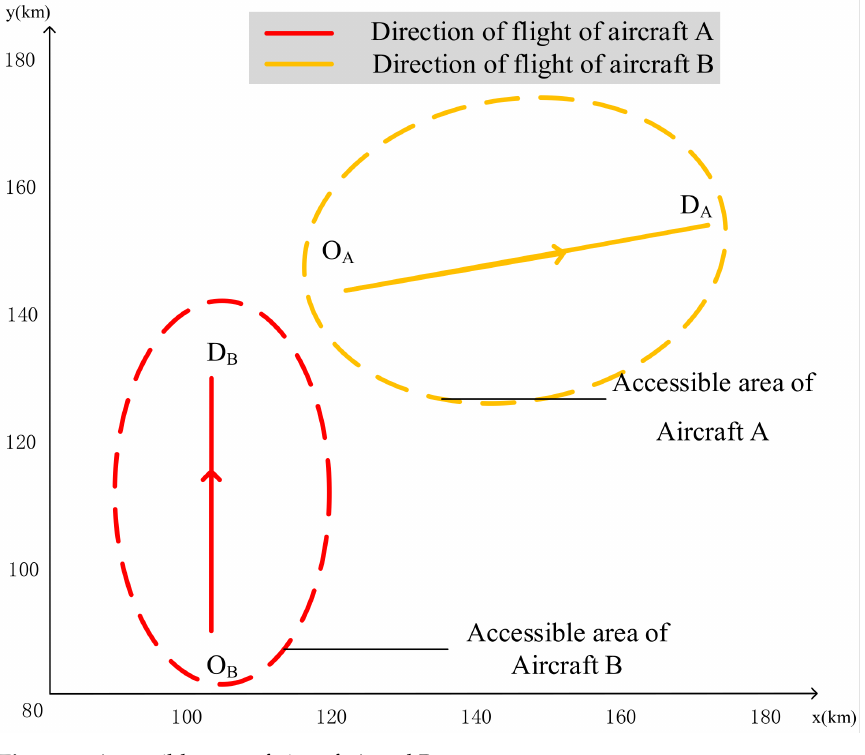
Figure 5. Accessible area of aircraft A and